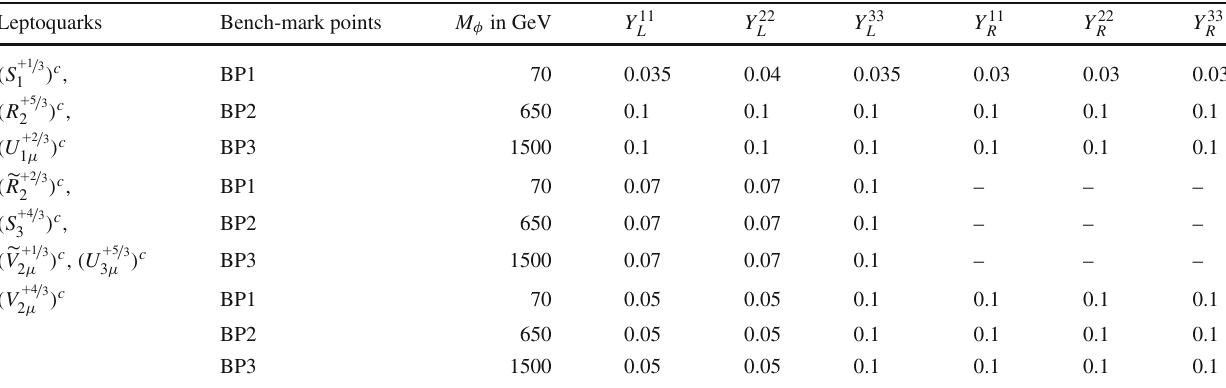
Table 2 Benchmark points for different leptoquark